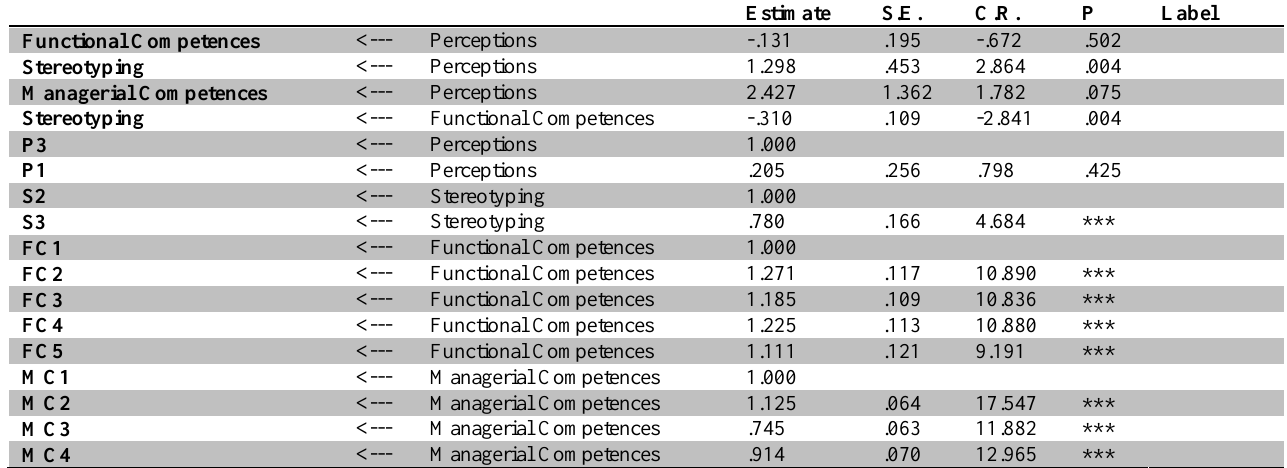
Table 7: Regression weights: (Group number 1 - Default model)